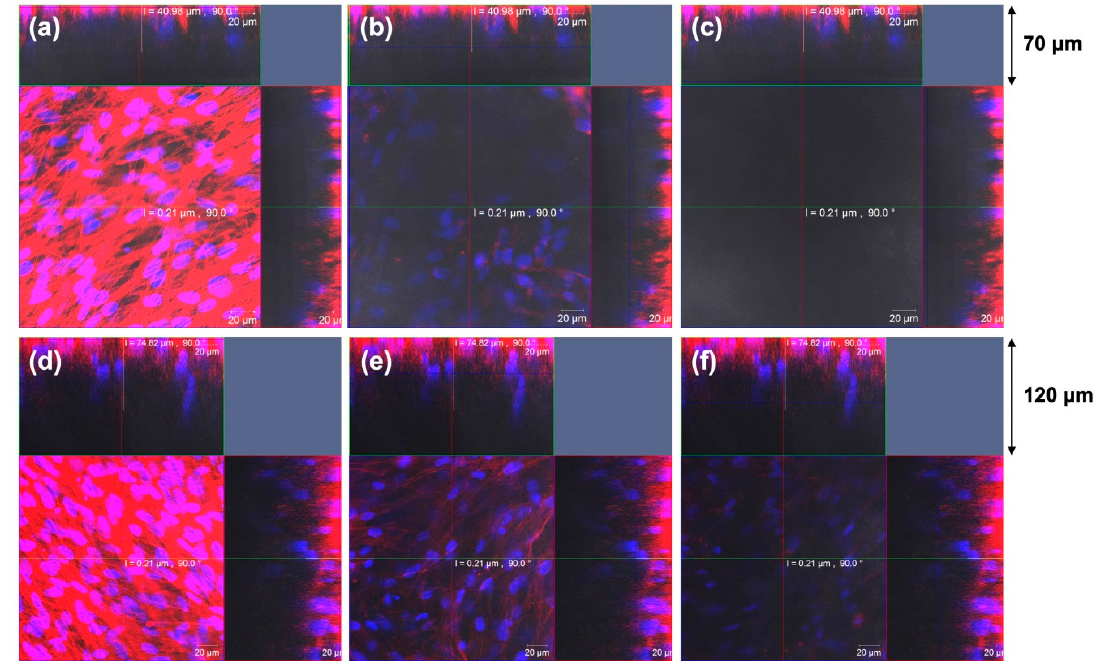
Figure 4. MSC proliferation on SNF was characterized by confocal laser scanning microscopy (CLSM) images after 7 days ( a – c ) and 14 days ( d – f ) culture at a cell density of 1.5 × 10 5 . Single optical slices are shown near to the SNF surface [1.76 μ m, ( a , d )], middle [36.96 μ m, ( b , e )], and bottom [66.87 μ m, ( c , f )]. Hoechst 33,342 (blue) and Alexa Fluor 594 phalloidin (red) were used to stain cellular nuclei and skeletons, respectively. Scale bars: 20 μ m. ACS Omega, Iijima et al. [36].